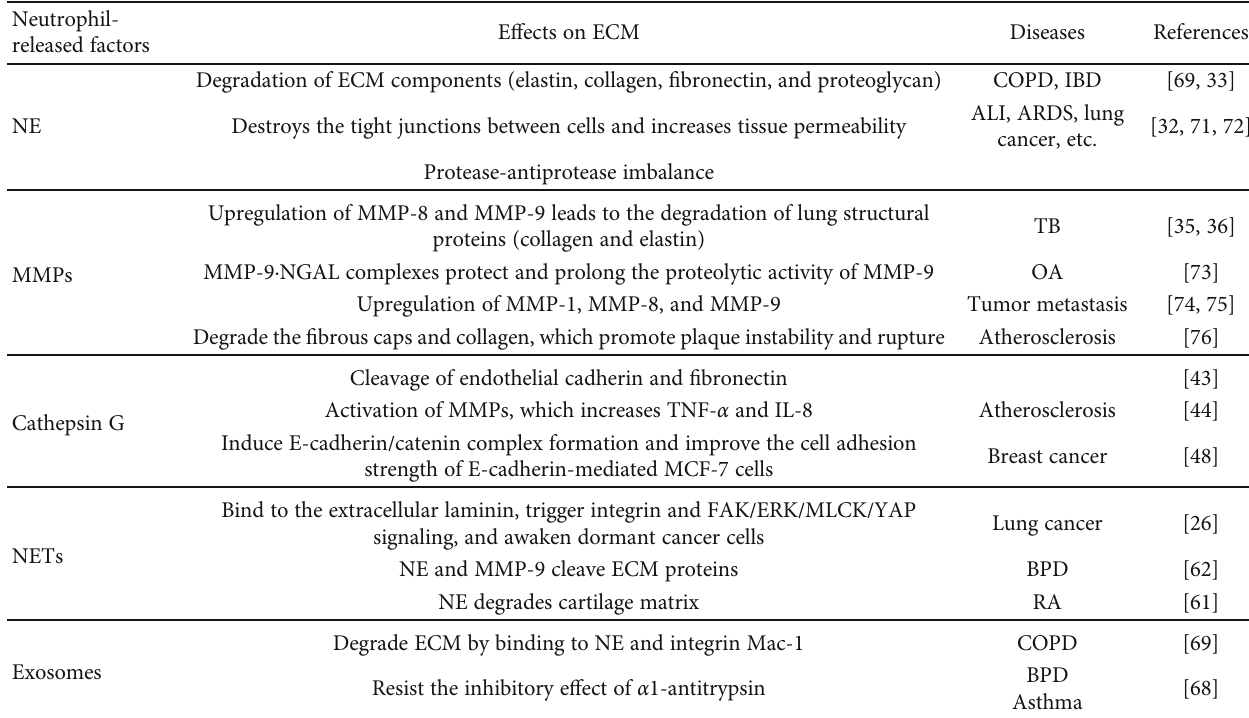
Table 1: E ff ects of neutrophil- released factors on extracellular matrix